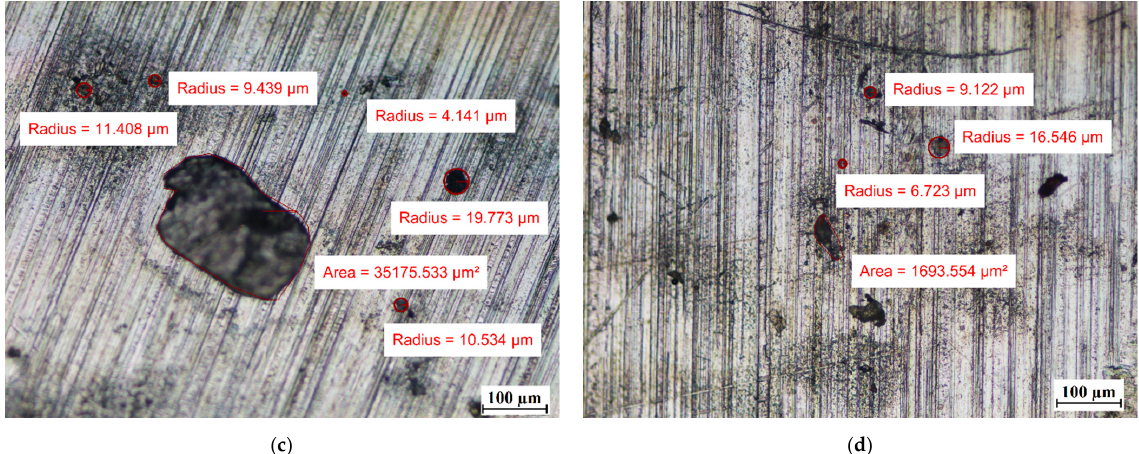
Figure 9. The surface of the aluminum samples (Al) ( a ) before immersion in PCM; ( b ) after 7 weeks immersion in RT15; ( c ) after 7 weeks immersion in RT18 HC; and ( d ) after 7 weeks immersion in RT22 HC.